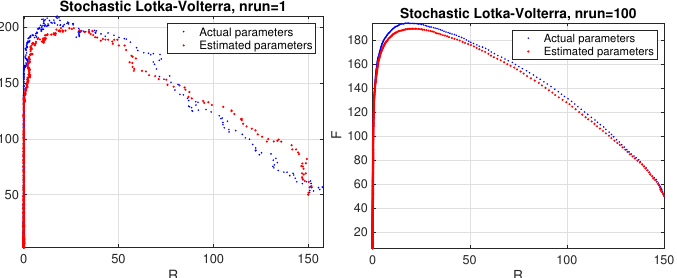
Figure 1. Predator–prey model. Phase space corresponding to a stochastic simulation of the Lotka– Volterra model using the estimated parameters (red color) compared to the actual ones (blue color). Results are shown for a single trial ( left panel ) and average over 100 trials ( right panel ).